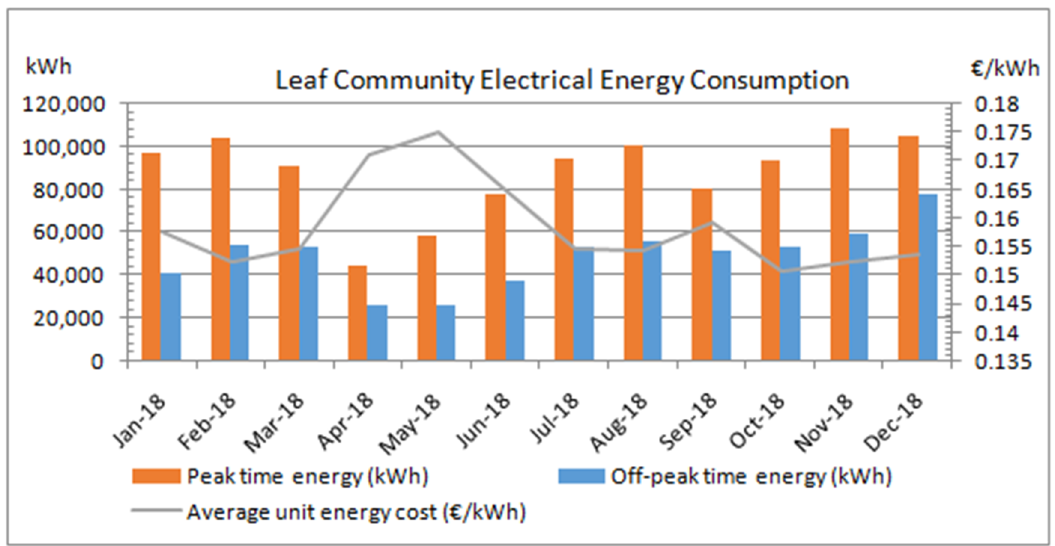
Figure 2. Leaf Community electrical energy consumption and unit cost of energy in 2018.